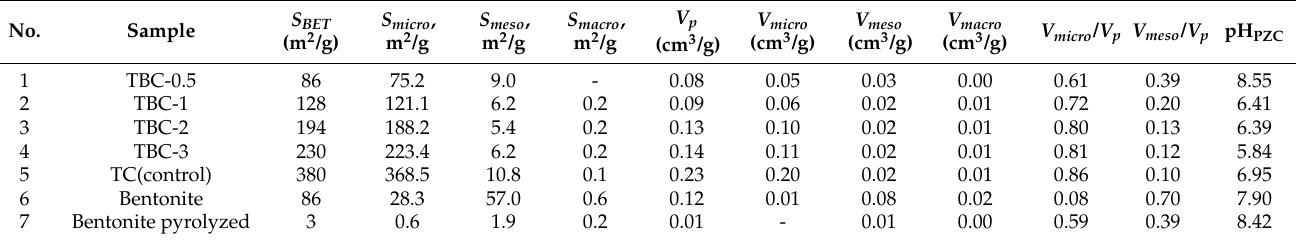
Figure 5. Nitrogen adsorption/desorption isotherms ( a ) and pore size distributions ( b ) of biochars: 1—TC (control), 2—TBC-3, 3—TBC-2, 4—TBC-1, 5—TBC-0.5, 6—bentonite, 7—bentonite pyrolyzed. Bulk density versus carbon content is in the insertion. Table 3. Porous characteristics and pH PZC for the studied